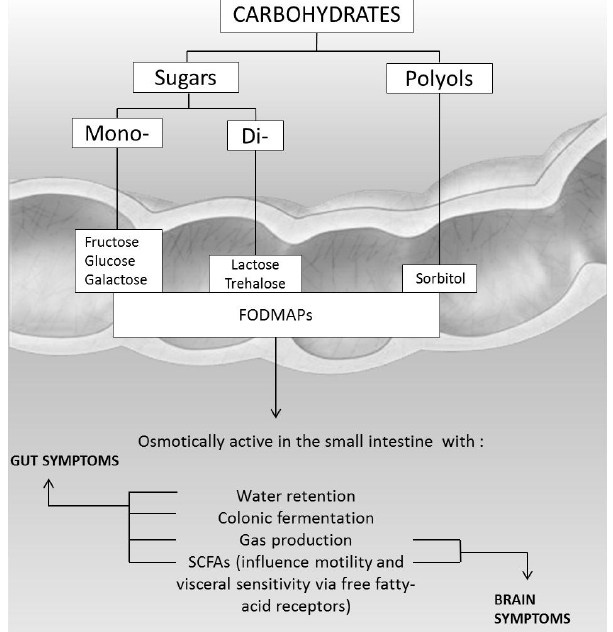
Figure 4. Pathogenesis of gut and brain symptoms in patients with intolerance to carbohydrates.